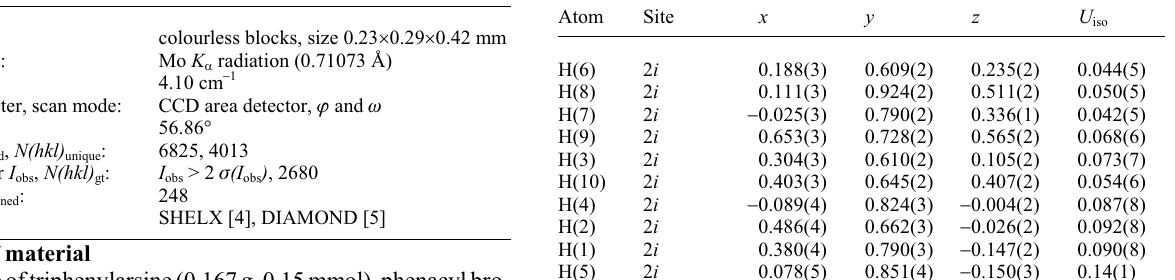
Table 2. Atomic coordinates and displacement parameters (in Å 2 )